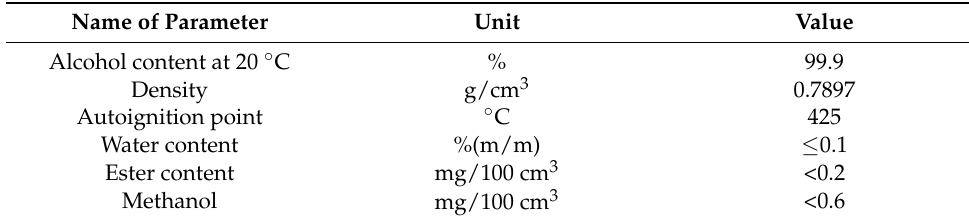
Table 2. Basic properties of ethyl alcohol [51].